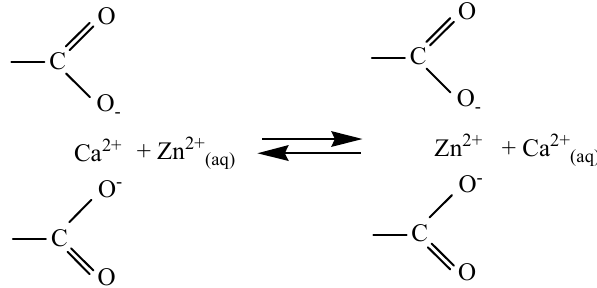
15 of 20 Figure 11. Schematic representation of Zn (II) sorption on GG/GO at pH 6. ( A ): before sorption; ( B ): after sorption.